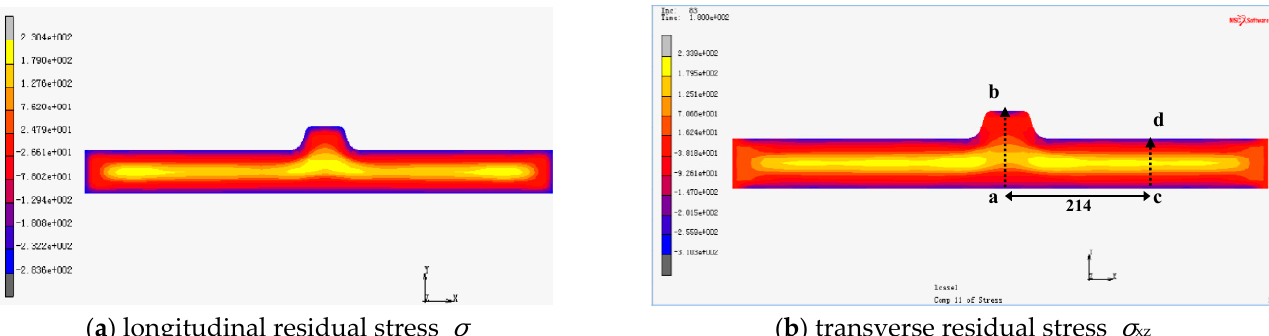
Figure 5. Residual stress distribution of quenched T-type rib: ( a ) Longitudinal residual stress; ( b ) transverse residual stress.